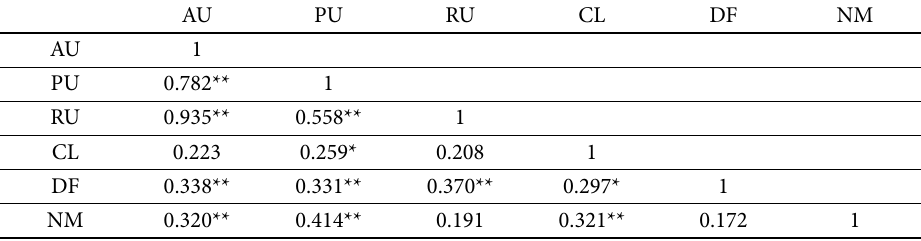
Table 4. Pearson correlations of the use of ISDM and Enterprise Productivity Measures AU PU RU CL DF NM AU 1 PU 0.782** 1 RU 0.935** 0.558**